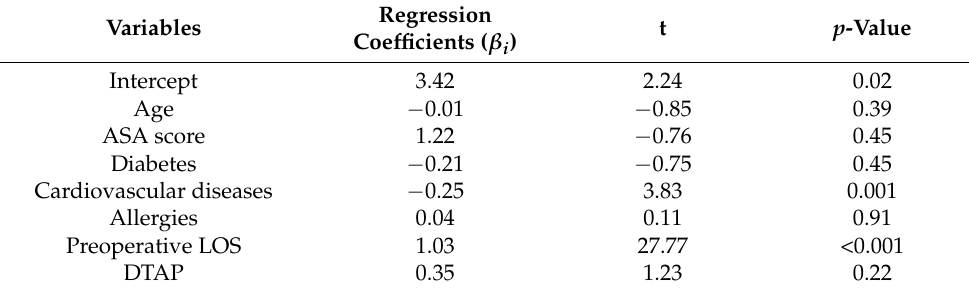
Table 3. Coefficients of the multiple linear regression